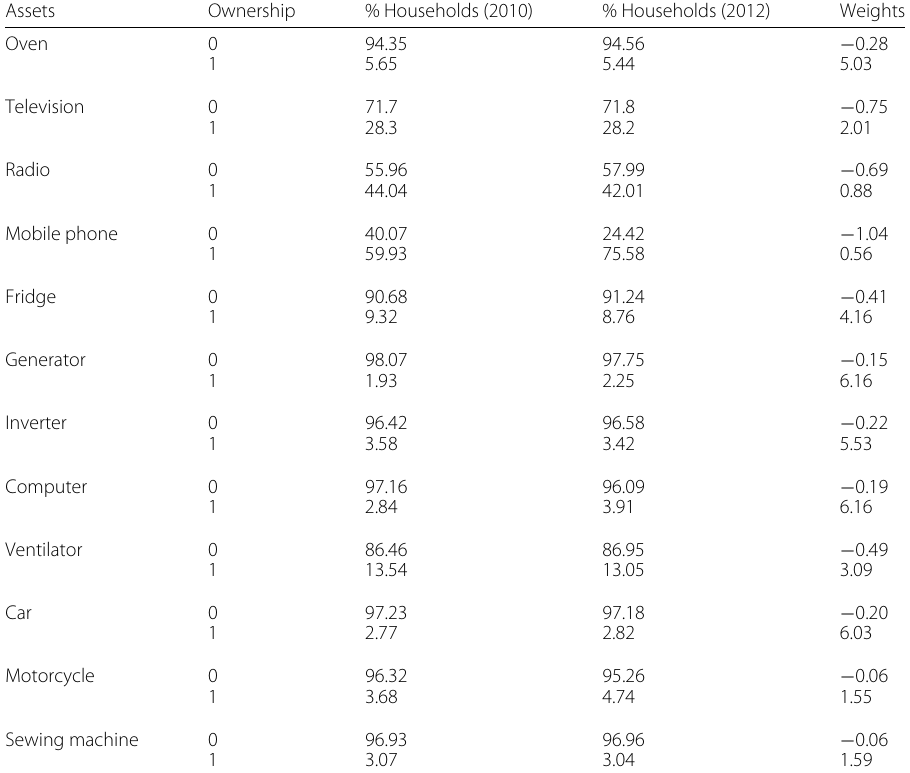
Table 8 Asset ownership and weights obtained from